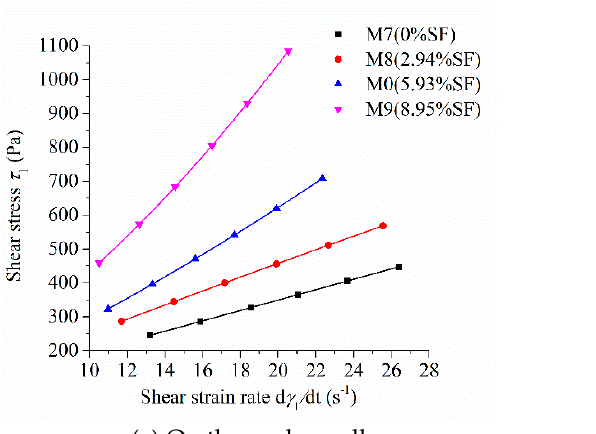
Molecules 2021 , 26 , x FOR PEER REVIEW 17 of 21